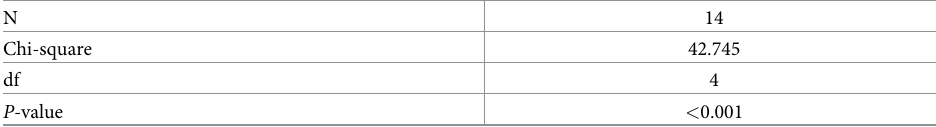
Table 8. Friedman test results of the five models on the relationship scores.